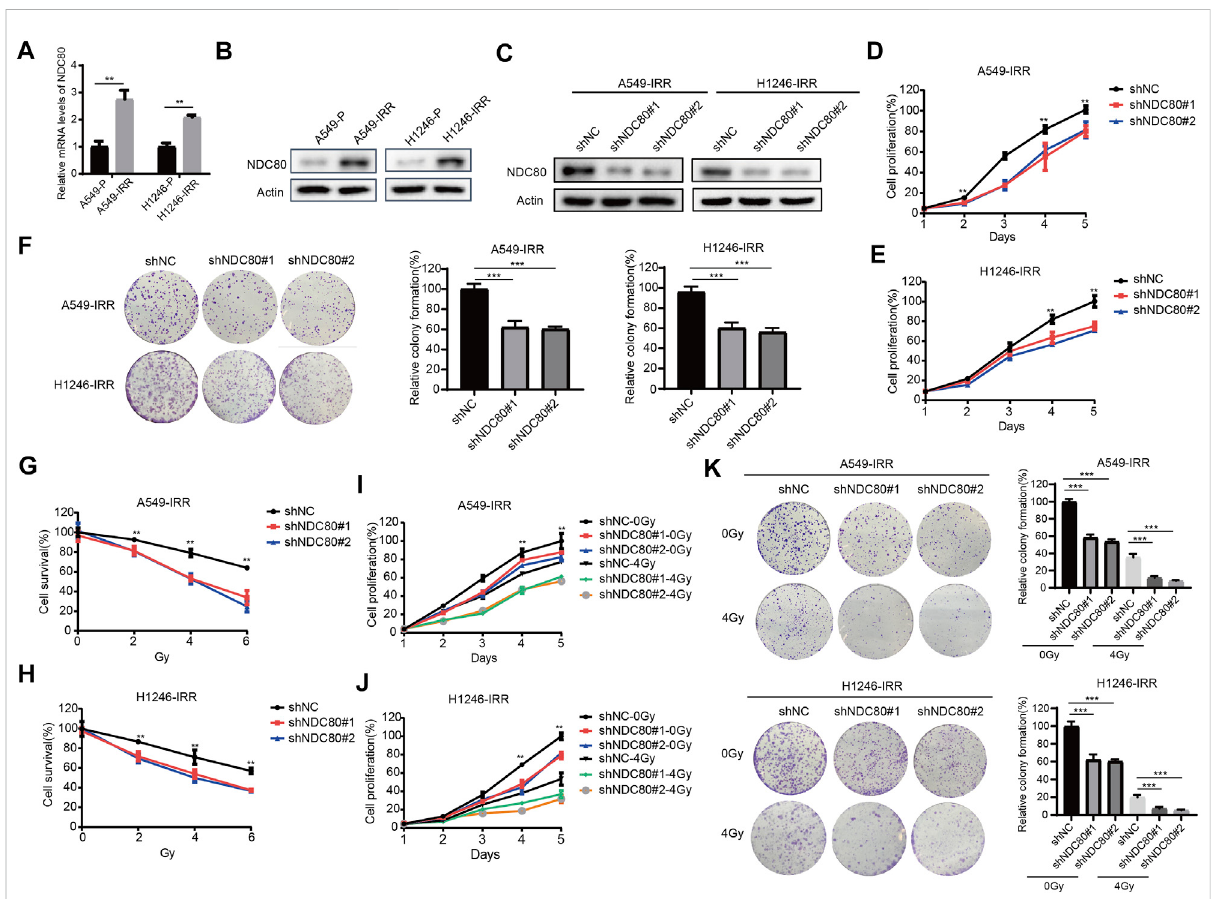
FIGURE 4 Knockdown of NDC80 increases the radiosensitivity of lung cancer cells. (A,B) The mRNA (A) and protein (B) expression of NDC80 was examinedinA549andH1246parentalandIR-resistantcells. (C) Afterthestable knockdown ofNDC80inA549-IRR andH1246-IRRcells,theprotein expression of NDC80 was analyzed using the Western blot assay. (D,E) Cell proliferation was examined in A549-IRR (D) and H1246-IRR (E) cells with shNC or shNDC80. (F) Colony formation was analyzed in A549-IRR and H1246-IRR cells via the stable reduction of NDC80. (G – H) Dose- dependent cell viability (exposure to 0,2,4,6 Gy) was examined in A549-IRR (G) and H1246-IRR cells (H) with NDC80 knockdown. (I – K) A549-IRR andH1246-IRRcellswithshNCorshNDC80wereexposedtoirradiationatadoseof4 GyandevaluatedviaCCK-8assays (I,J) andcolonyformation assays (K) . * p < 0.05; ** p < 0.01; *** p <